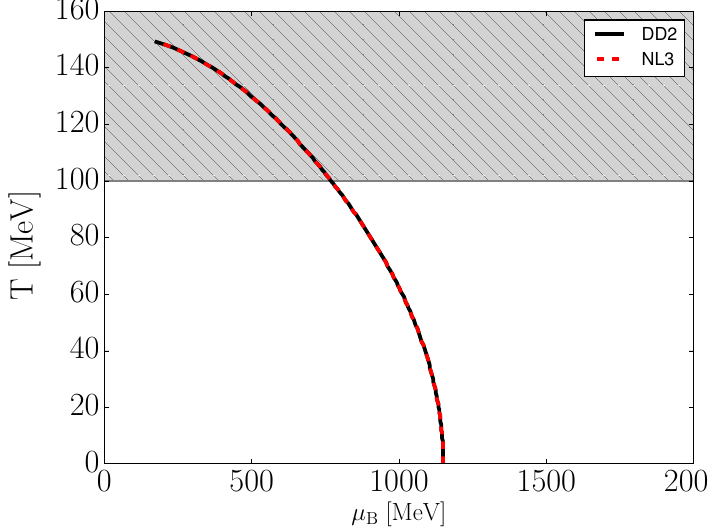
Figure 2. The T – µ B phase space of vBag ( B 1/4 χ = 152.7 MeV, K v = 6 The grey region lies outside of the models expected applicability domain. See text for